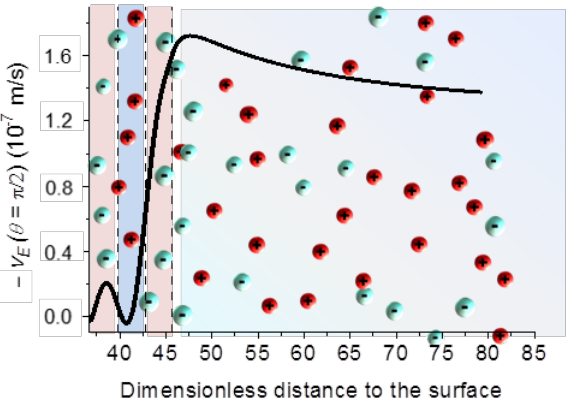
Figure 6. Tangential velocity profile (parallel to the external field, 0  ) for the case shown in Figure